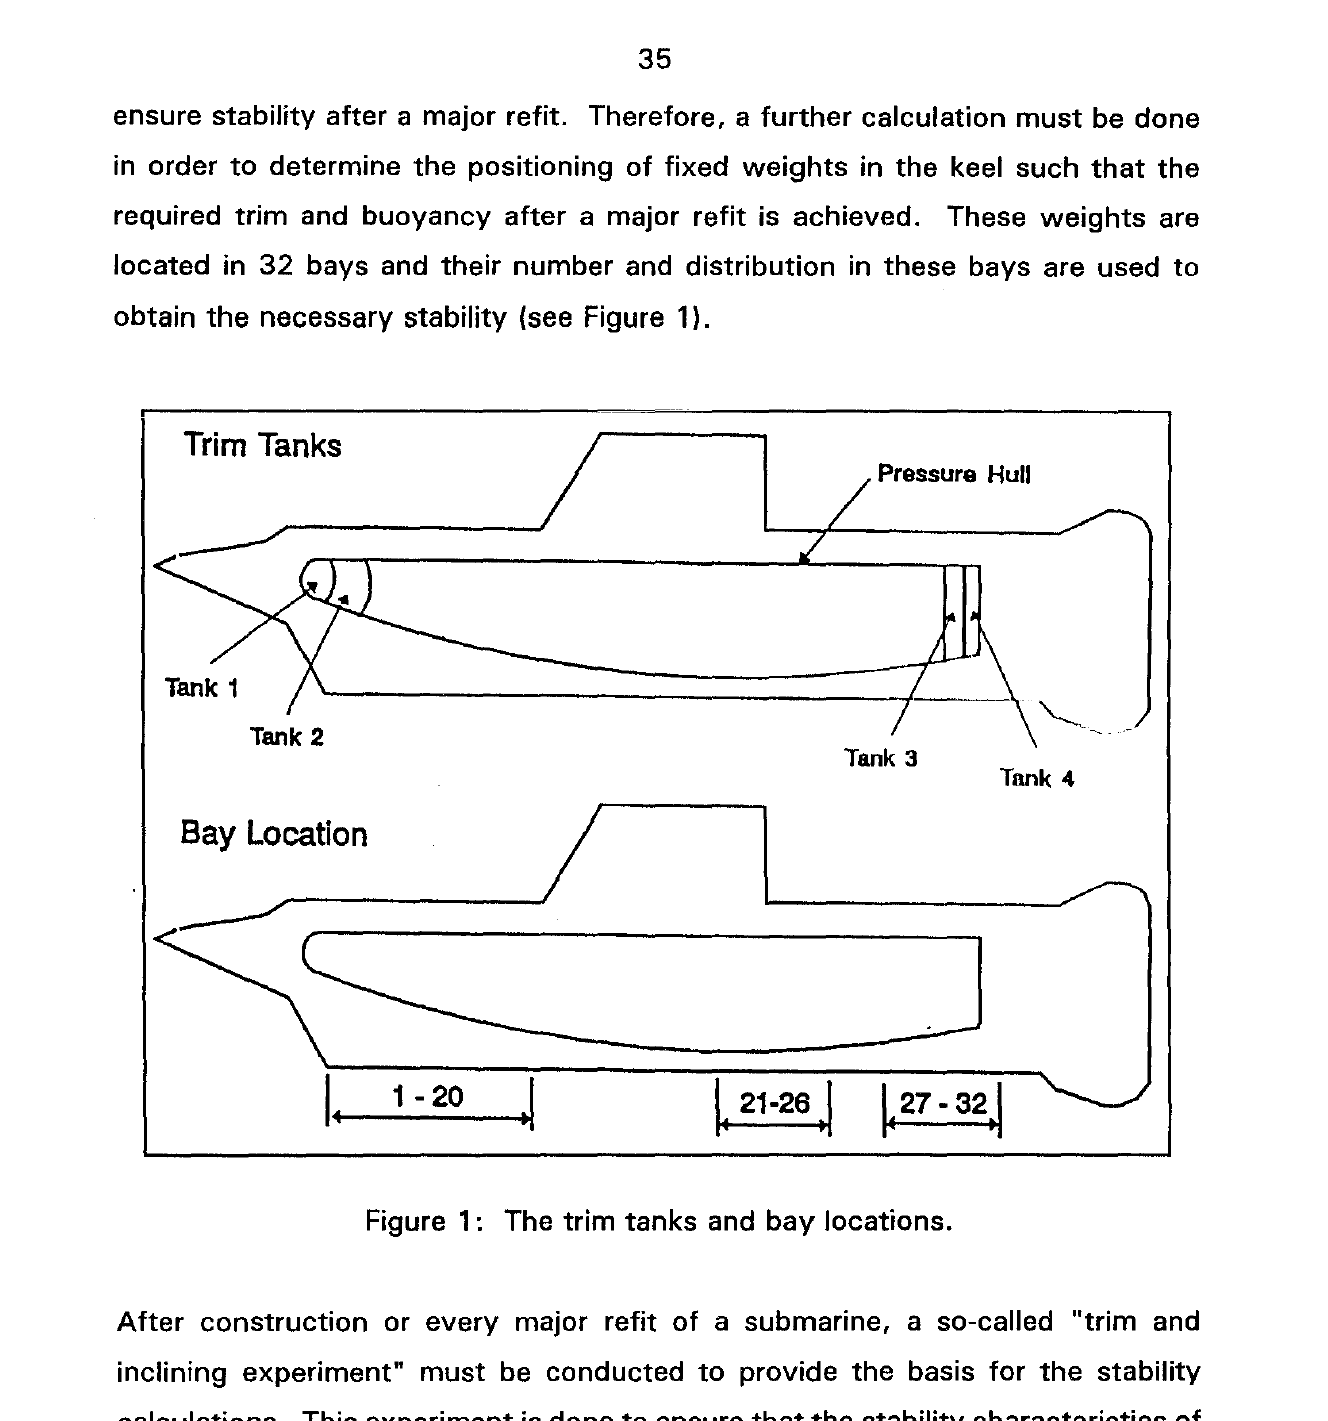
Figure 1 : The trim tanks and bay